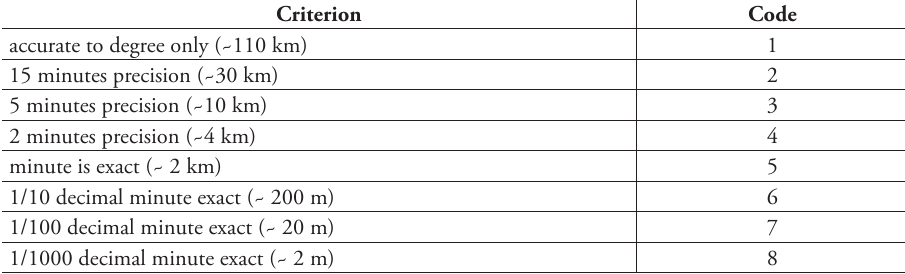
Table 1. Accuracy code given to georeferenced records and corresponding uncertainty in